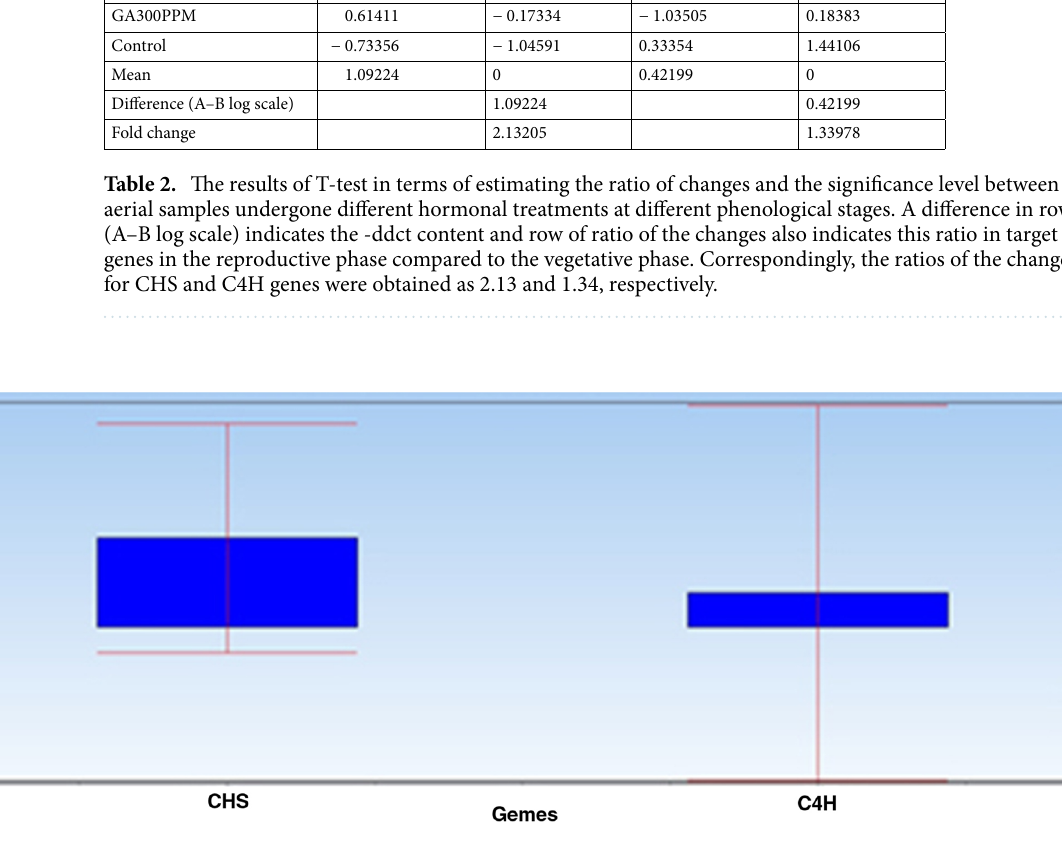
Figure 4. The difference between the mean expressions of target genes in the reproductive phase compared to the vegetative phase. As can be observed, both C4H and CHS target genes overexpressed in the reproductive samples compared to the vegetative samples. However, the overall expression of CHS gene in the reproductive phase was almost twice of that of the vegetative phase. However, in the C4H gene, this overexpression occurred with less intensity (less than 1.5 times).